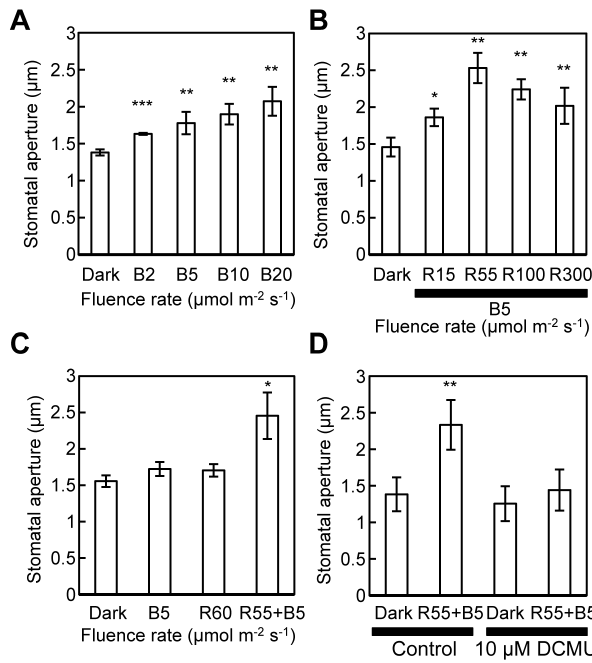
Figure 1. BL-dependent stomatal opening enhanced by RL- activated guard cell photosynthesis. A–D, BL-induced stomatal opening in isolated epidermal tissues of Arabidopsis. A, Stomatal aperture after 2 h incubation in darkness (Dark) or under BL at various fluence rates (B2, B5, B10, and B20 represent 2, 5, 10, and 20 m mol m 2 2 s 2 1 of BL, respectively). B, Stomatal aperture after 2 h incubation in darkness or under BL (B5) superimposed on RL at various fluence rates (R15, R55, R100, and R300 represent 15, 55, 100, and 300 m mol m 2 2 s 2 1 of RL, respectively). C, Stomatal aperture after 2 h incubation in darkness or under 5 m mol m 2 2 s 2 1 BL (B5), 60 m mol m 2 2 s 2 1 RL (R60), or 5 m mol m 2 2 s 2 1 BL plus 55 m mol m 2 2 s 2 1 RL (R55 + B5). D, Stomatal aperture after 2 h incuba- tion in darkness or under simultaneous irradiation with BL and RL (R55 + B5), with or without DCMU. Data shown are means 6 SE of four (A) or three (B–D) independent experiments. For each light condition in an experiment, the apertures of 45 stomata were determined. Asterisks indicate the statistically significant differences compared to Dark control (without DCMU in D), assessed by Student’s t -tests (*: 0.05 , P , 0.1, **: 0.01 , P , 0.05, ***: P , 0.01).